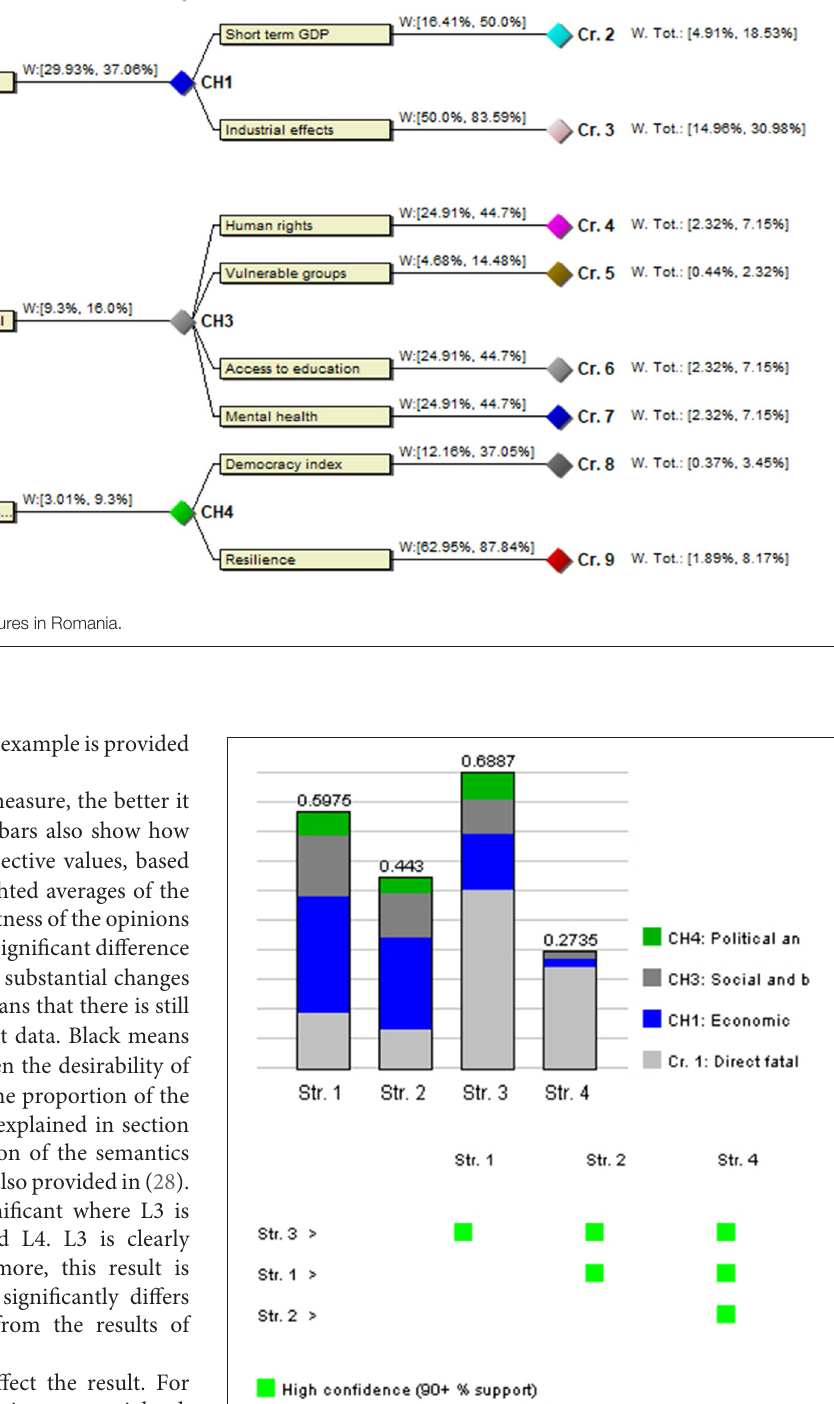
Frontiers in Public Health |